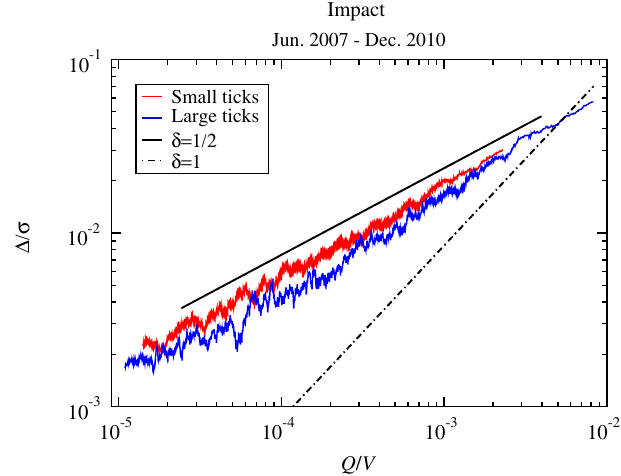
FIG. 1. The impact of metaorders for Capital Fund Management proprietary trades on futures markets, in the period from June 2007 to December 2010. Impact is measured here as the average execution shortfall of a metaorder of size Q . The data base contains nearly 500 000 trades. We show (cid:1) =(cid:1) vs Q=V on a log-log scale, where (cid:1) and V are the daily volatility and daily volume measured the day the metaorder is executed. The blue curve is for large tick sizes, and the red curve is for small tick sizes. For large ticks, the curve can be well fit with (cid:2) ¼ 0 : 6 , while for small ticks we find (cid:2) ¼ 0 : 5 . For comparison, we also show the lines of slope 0.5 (corresponding to a square-root impact) and 1 (corresponding to linear impact). We have re- moved a small positive intercept (cid:1) =(cid:1) ¼ 0 : 0015 for Q ¼ 0 , which is probably due to a conditioning